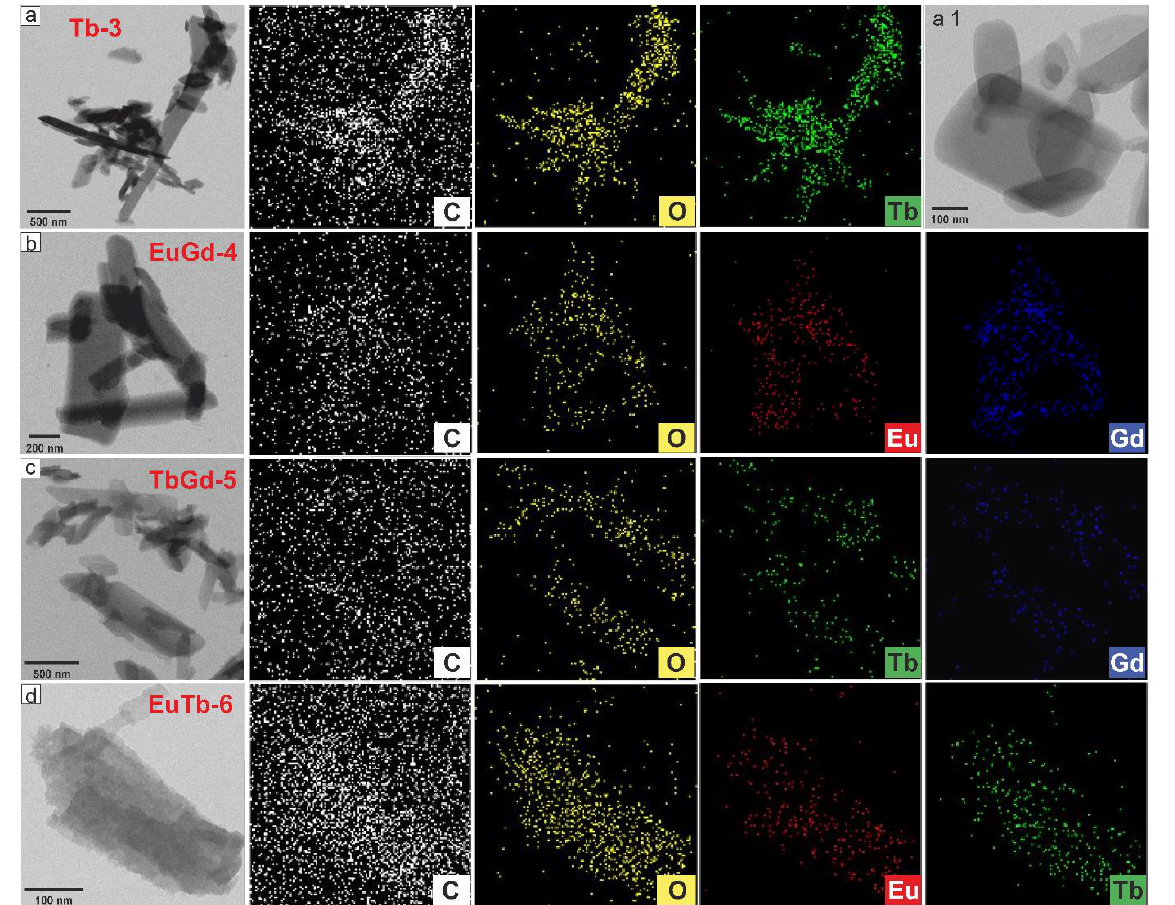
Figure 6. STEM images and EDS elemental mapping of the LnMOF powders: ( a ) Tb-3, ( b ) EuGd-4, ( c ) TbGd-5 and ( d ) EuTb-6 samples.